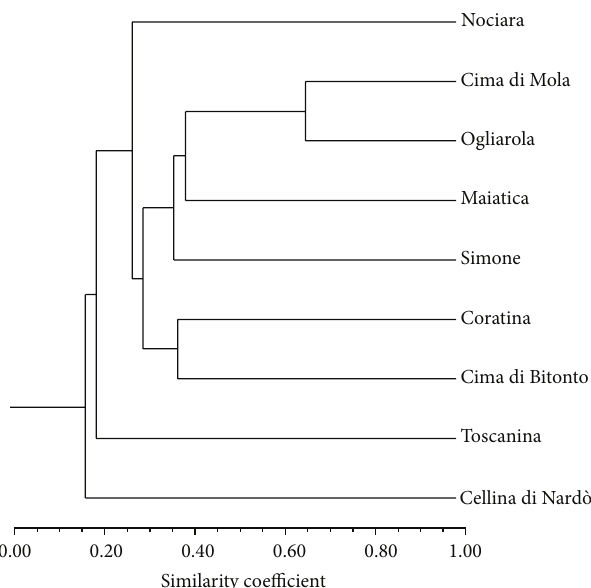
Figure 1: Genetic similarity dendrogram of nine olive cultivars obtained by the analysis of seventeen microsatellite markers.